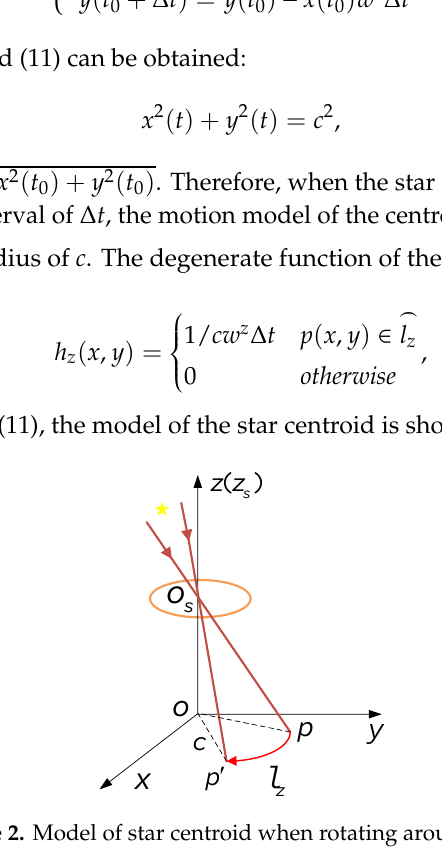
xy l Figure 3. Model of star centroid when rotating around the X and Y axes.